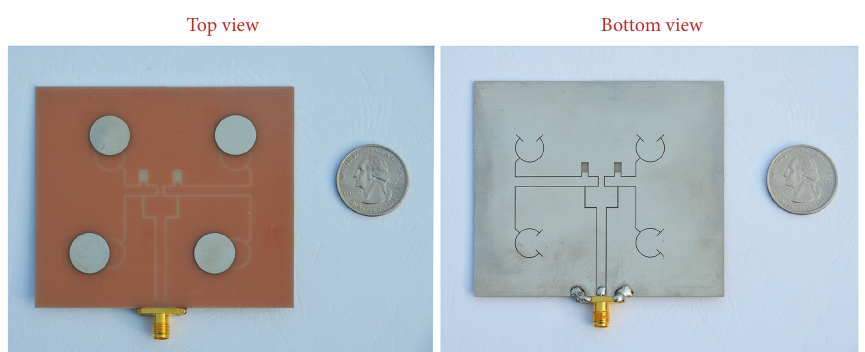
Figure 7: Top view and bottom view of the 2 × 2